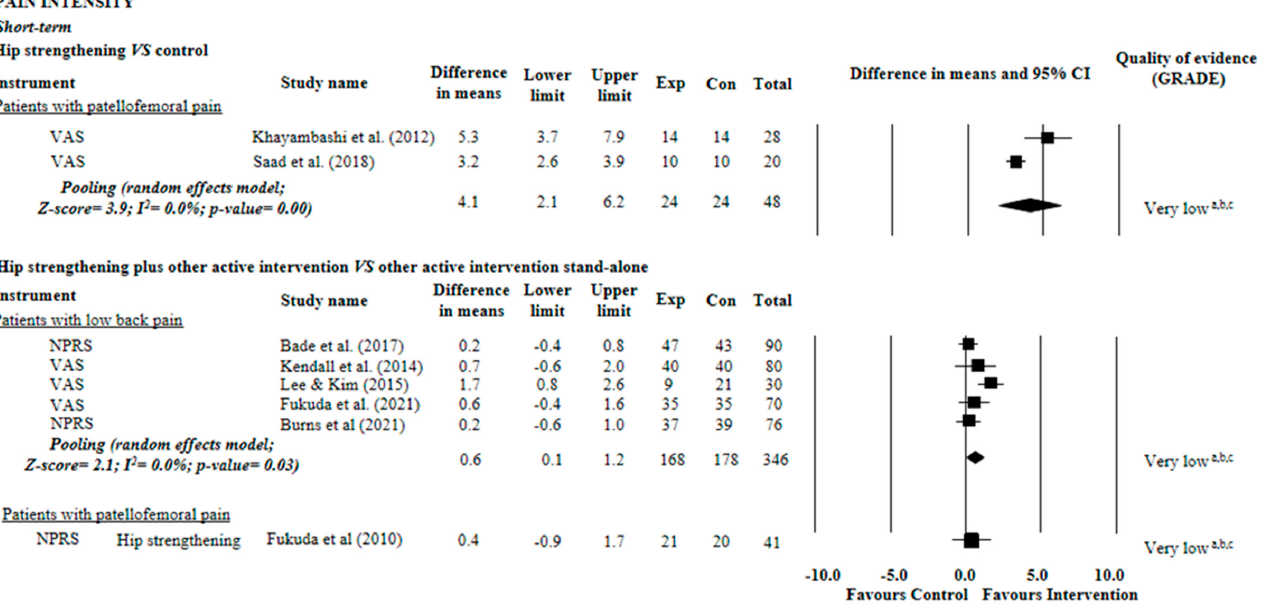
Figure 2. Summary of evidence of effect of hip strengthening on pain. Control: sham, placebo, no intervention, or waiting list. (a) Downgraded owing to impreci- sion: less than 400 participants included in the meta-analysis (sample of less than 200 was considered serious imprecision, and the evidence was downgraded by two levels); (b) Downgraded owing to inconsistency: I 2 statistic was higher than 50% or pooling was not possible (poor overlap between the confidence intervals of the effects of the studies included in the meta-analysis was considered serious inconsistency, and the evidence was downgraded by two levels); (c) Downgraded owing to risk of bias: more than 25% of the participants in the meta-analysis were from trials with a high risk of bias (i.e., PEDro score < 6 of 10) [30–33,35–38].